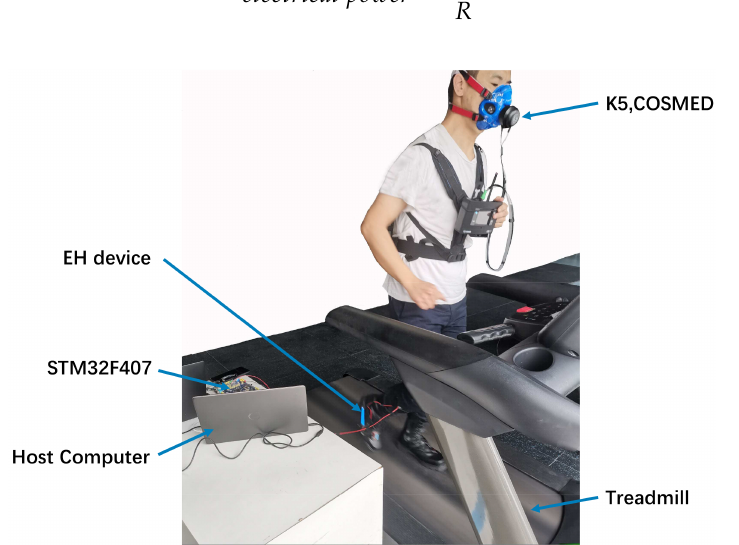
Figure 5. The subject walks on a treadmill at different speed of 4 km/h, 5 km/h, 6 km/h, 7 km/h, and 8 km/h, respectively. The K5 is used to monitor the rate of Oxygen consumption and Carbon dioxide production. An ADC of STM32F407 is used to record the voltage of